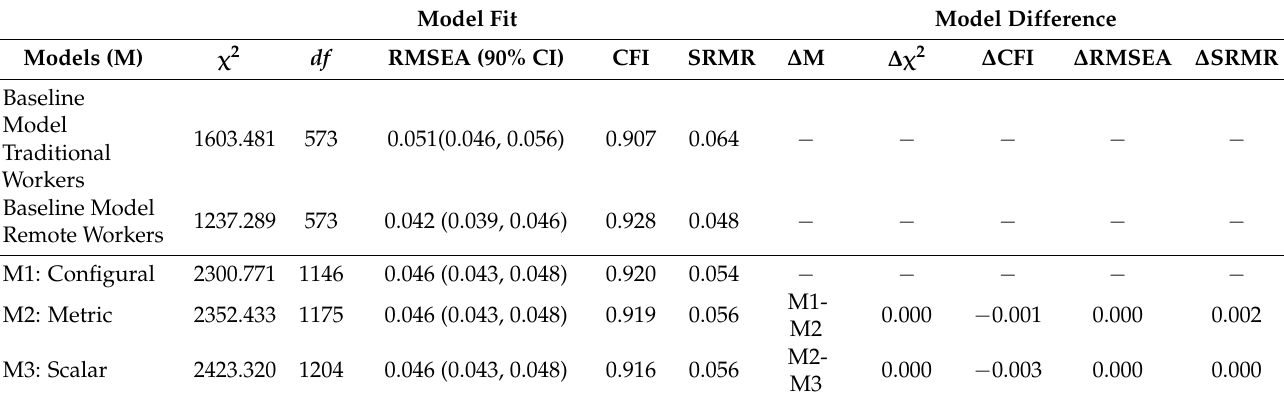
Table 3. Results of Tests for Measurement Invariance across Traditional and Remote Workers. Model